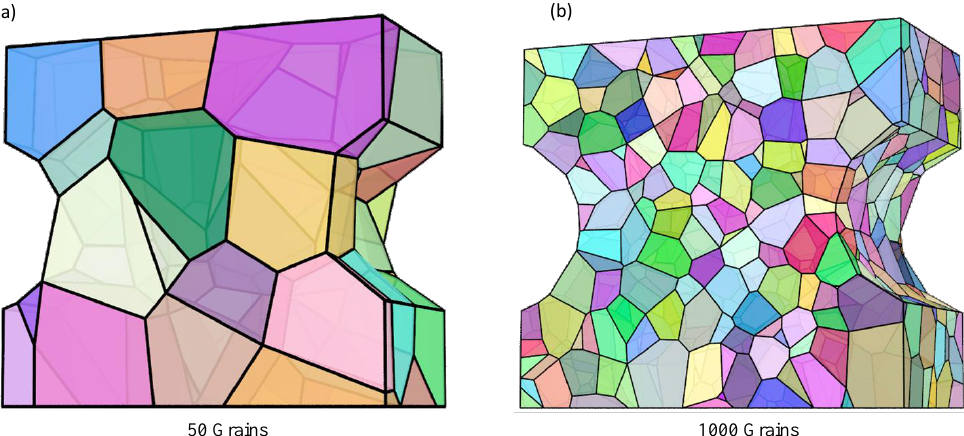
Figure 4. Polycrystalline models of the notched specimen, coarse-grain with 100 grains ( a ), fine grain with 1000 grains ( b ). A detailed description of the model properties of the smooth specimen as well as generation is described in [17]. In order to expand the simulation database, six coarse- grain smooth models with random orientation distributions and six fine-grain smooth